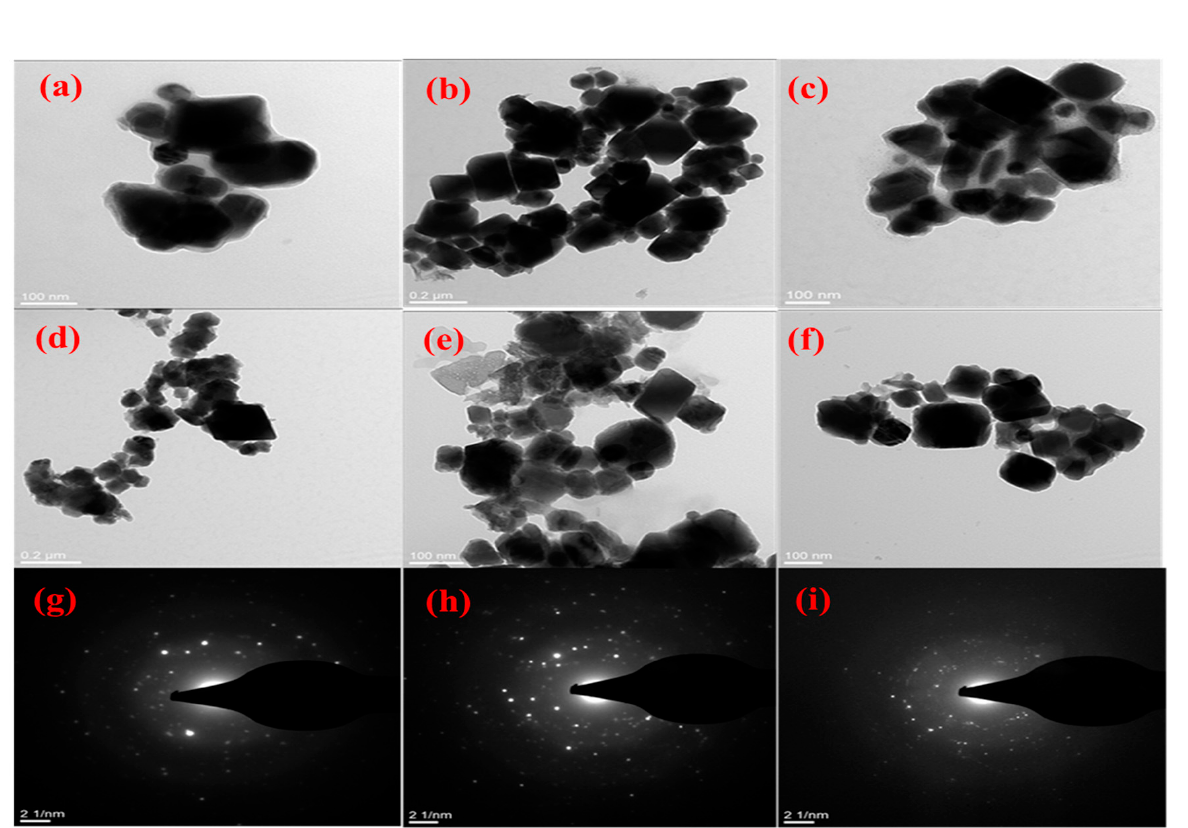
Figure 6. TEM images of Cu x S y nanoparticles prepared in ( a , d ) OLA, ( b , e ) HDA, and ( c , f ) DDA at 190 °C using complexes 1 and 2; SAED patterns of nanoparticles prepared in ( g ) OLA, ( h ) HDA, and ( i ) DDA at 230 °C from complex 1.